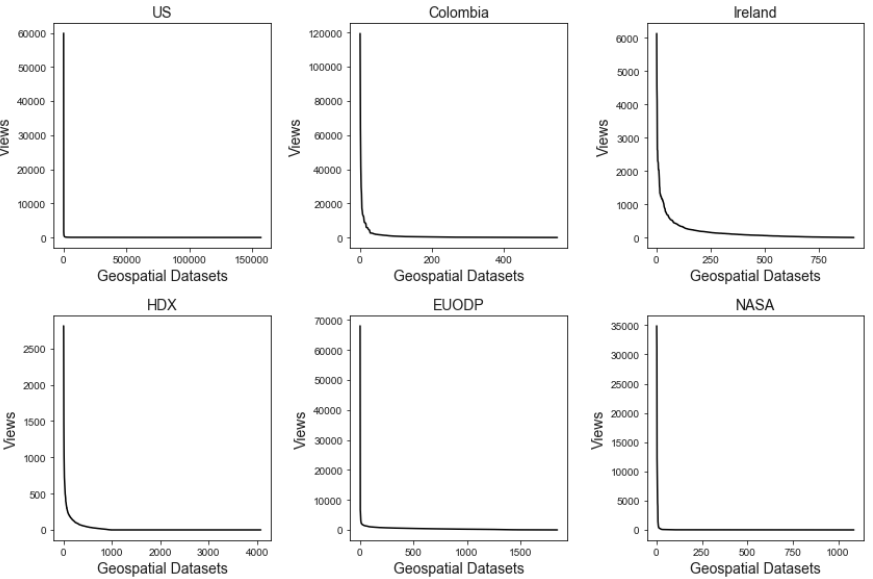
Figure 1. Number of Views distributions for the geospatial datasets of the National and the interna- tional OGD portals (total views up to December